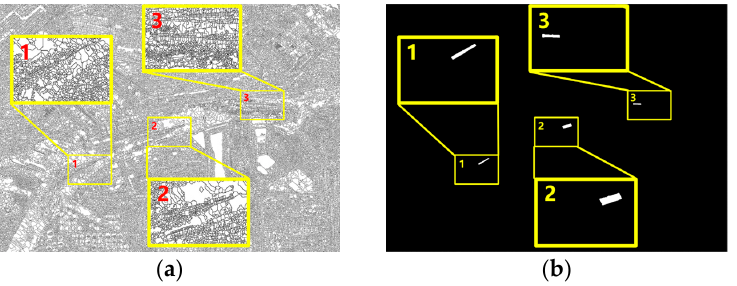
Figure 10. The comparison between traditional and marker-based watershed segmentation: ( a ) Traditional watershed result; ( b ) Marker-based watershed result.